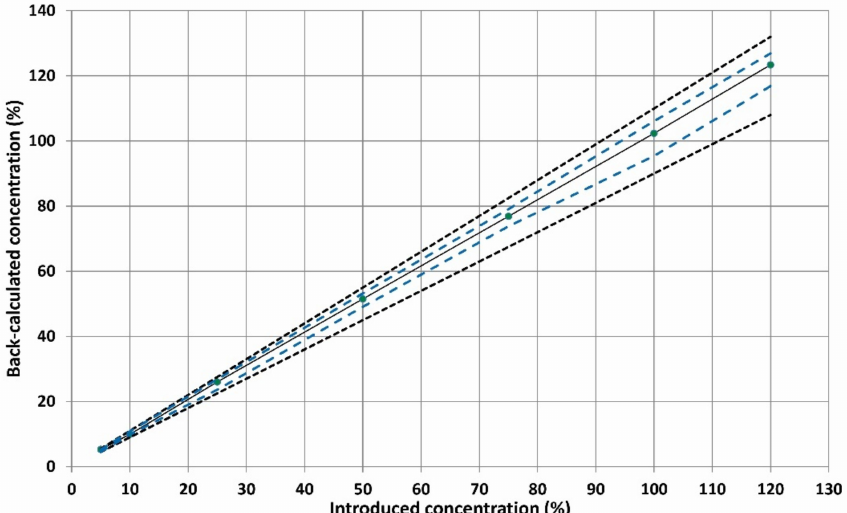
a k : m and n correspond to the number of experiments, calibration levels and replicates, respectively. b s (%): relative standard deviation under repeatability conditions. c s R (%): relative standard deviation under intermediate precision.